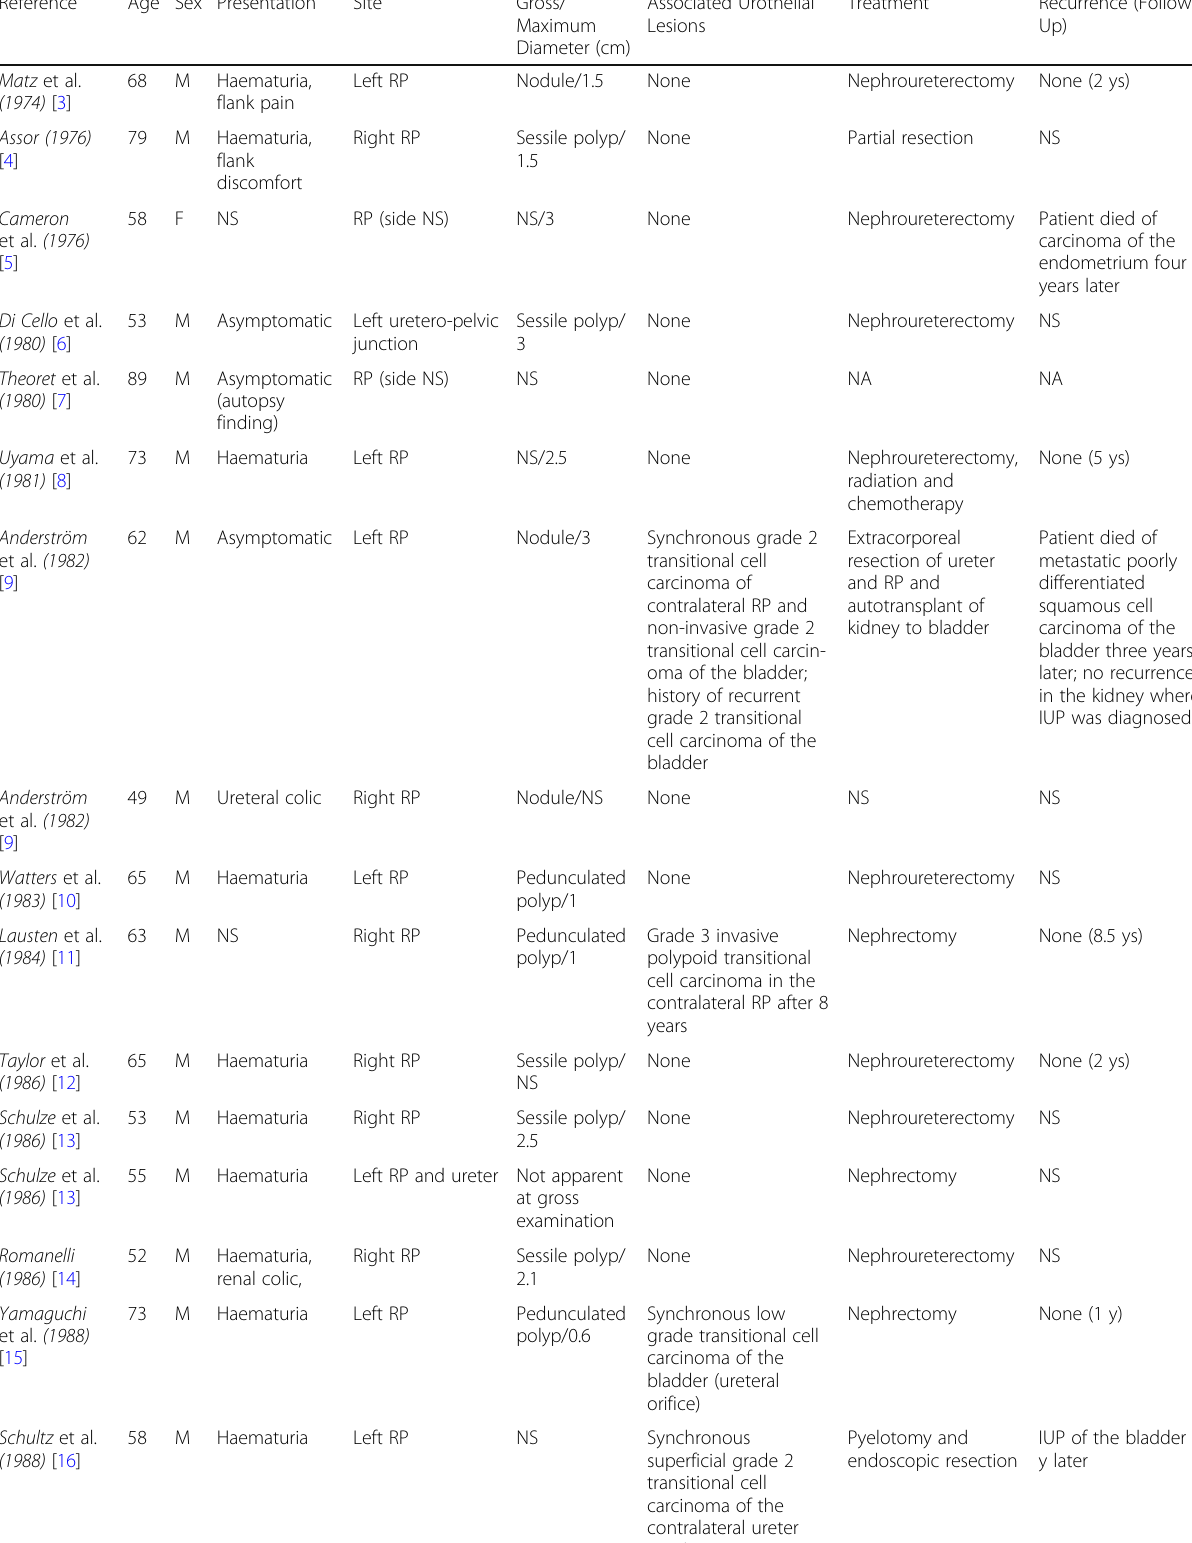
Table 1 IUP of the renal pelvis (RP) previously reported in the English Literature (NS = Not Stated; NA = Not Assessed)